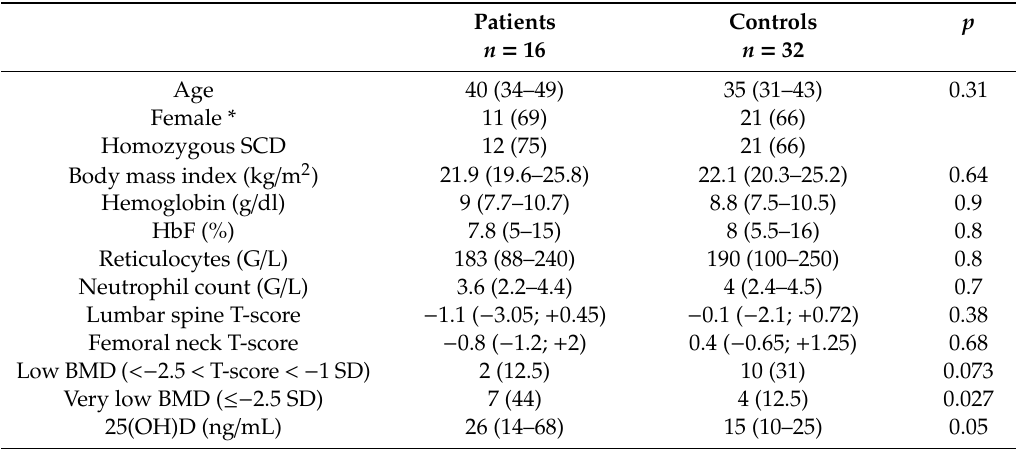
Table 3. Comparison of bone mineral density (BMD) between SCD patients with pHPT and matched SCD controls without pHPT.